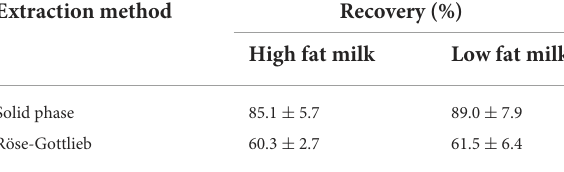
TABLE 2 Röse-Gottlieb and solid phase extraction of lipids from human breast milk. Extraction method